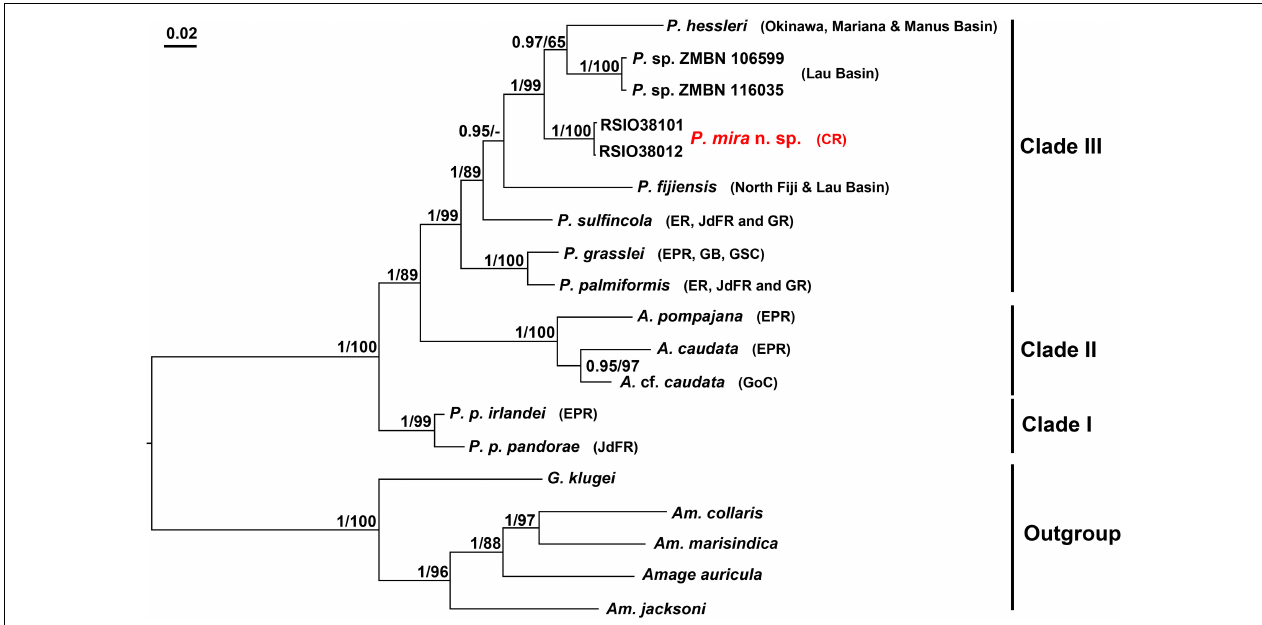
FIGURE 5 | Phylogenetic reconstruction of alvinellids based on the concatenated alignments of COI, 16S and 18S using BI and ML analyses, imposed on the consensus BI tree. Node supports are given as PP/BS. Nodes that are not recovered in ML analyses are denoted as “ − ”; The new species, P. mira n. sp. is shown in red. Abbreviations: A., Alvinella ; Am., Amphisamytha ; G., Grubianella ; P., Paralvinella ; P. p., Paralvinella pandorae . Accession numbers of the sequences used are provided in Table 1